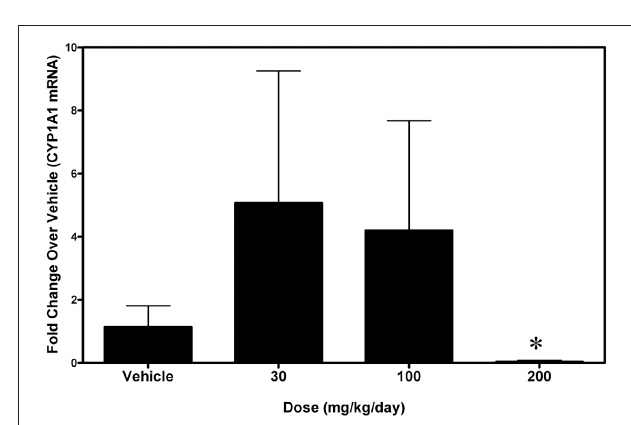
FIGURE 6 | Levels of Cyp1a1 mRNA in small intestine (jejunum) from rats treated with 30, 100, or 200mg/kg/day A-998679 compared to vehicle control animals. The data presentation is the same as described in Figure 3 (average ± SD). Note that at the 200mg/kg dose, the Cyp1a1 mRNA levels are substantially decreased (below the level of the vehicle controls). Marked bars indicate that the values were significantly different between treated and vehicle control rats ( ∗ p < 0 .